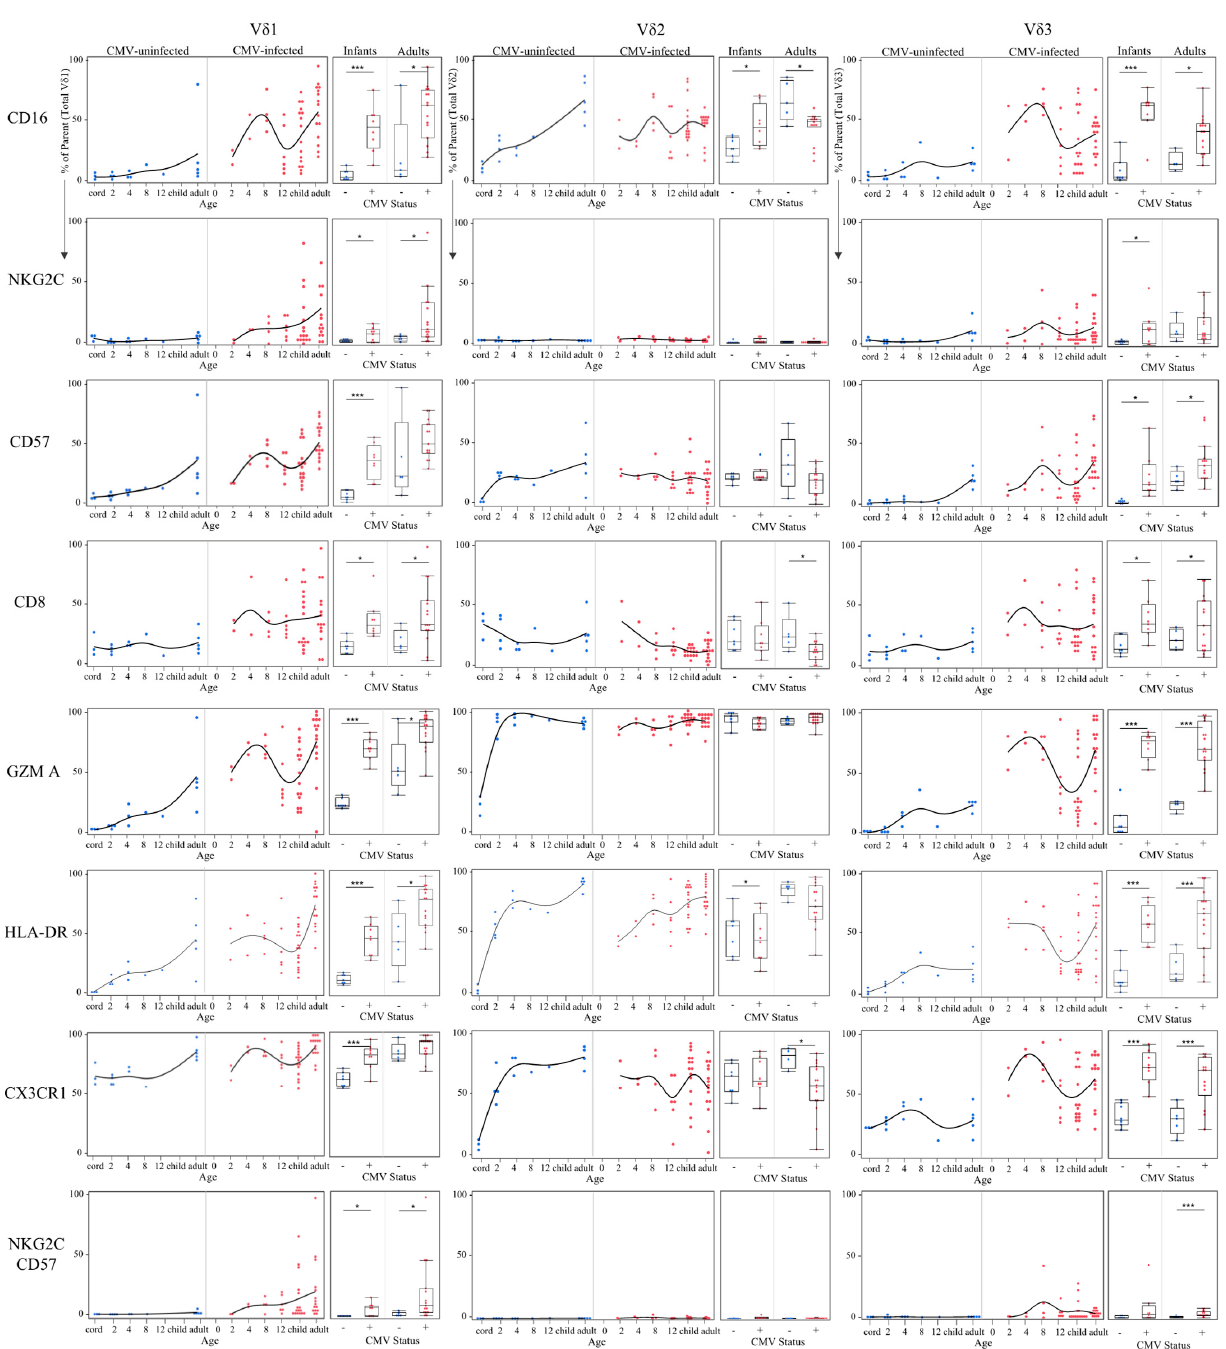
Figure 5. Temporal kinetics of γδ T cell δ -subsets suggest functional changes induced by CMV infection. Proportions of each phenotypic marker obtained from spectral flow cytometry were charted from either total V δ 1, V δ 2 or V δ 3 T cells were plotted by age (in months) and separated by CMV status (left plots). These same data were additionally grouped into Ugandan infants (2–12 months old; n = 15; CMV-infected n = 8 and CMV-uninfected n = 7) and adult subjects were Canadian ( n = 10; CMV-infected n = 5 and CMV-uninfected n = 5) and Ugandan mothers ( n = 11; all CMV-infected). Statistical differences between CMV-infected and uninfected infants and adults were determined using a Wilcoxon–Mann–Whitney test. Horizontal bars represent the median; boxes extend to the 25th and 75th percentile and whiskers represent the 95th percentiles; one asterisk (*) indicates p < 0.05, and three (***) indicates p < 0.001.